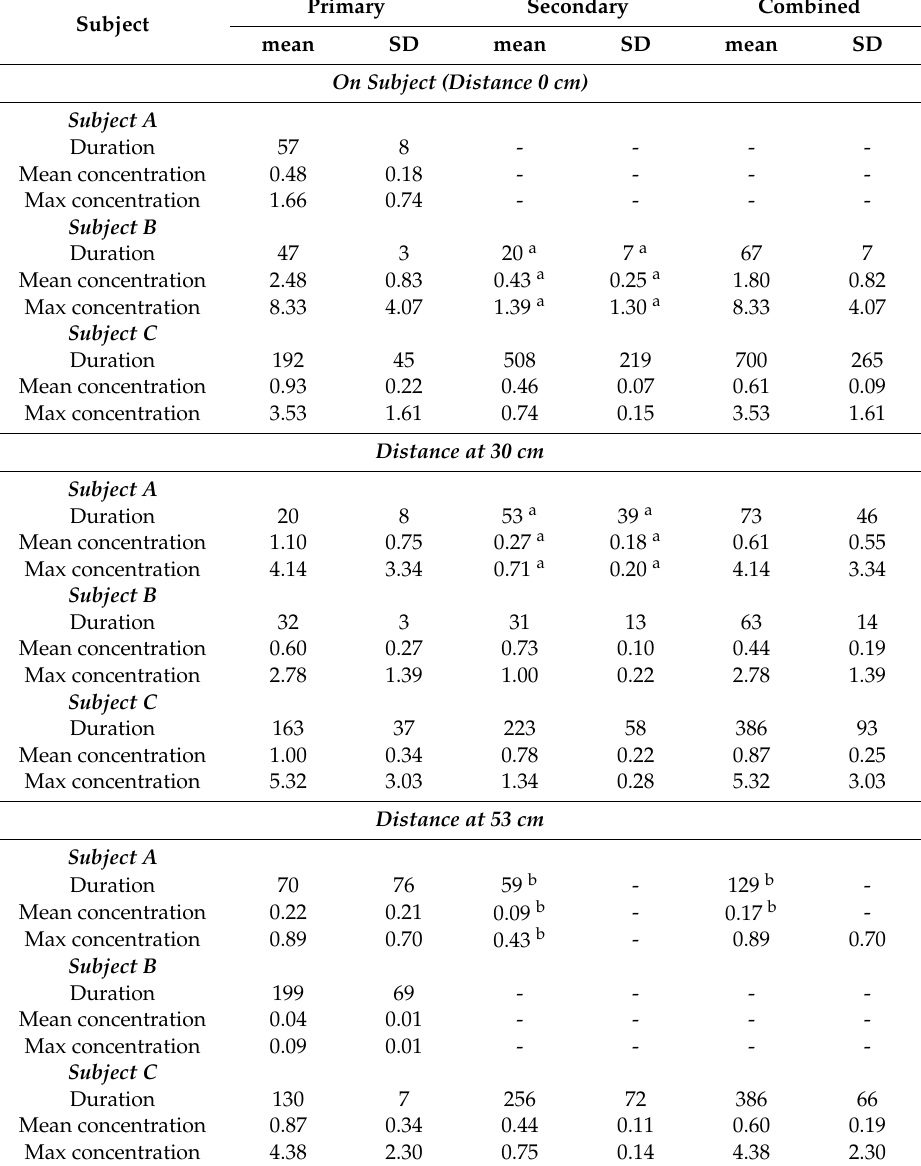
Table 4. Summary of PM 4 concentration (mg / m 3 ) and duration (s) of primary and secondary talc clouds formed during application by three subjects. Mean and standard deviation (SD) values are based on triplicate applications by each subject (secondary clouds occurred in all three replicates except where noted; dashes indicate absence of a secondary cloud). Simultaneous monitoring (at temperature 25.0–26.2 ◦ C and RH 43–48%) of personal breathing zone at 0 cm (top) and 30 cm from face (middle), with area measurement at 53 cm from the face